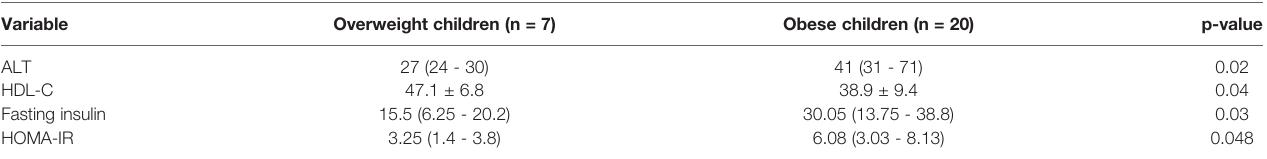
TABLE 3 | Biochemical differences between overweight and obese children. Variable